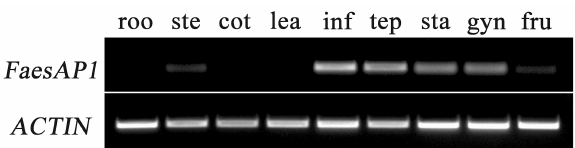
Figure 4. FaesAP1 expression in the roots (roo), stems (ste), cotyledons (cot), juvenile leaves (lea), inflorescence (inf), tepals (tep), stamens (sta), gynoecia (gyn), and fruits (fru) by sqRT- PCR with ACTIN as the control.